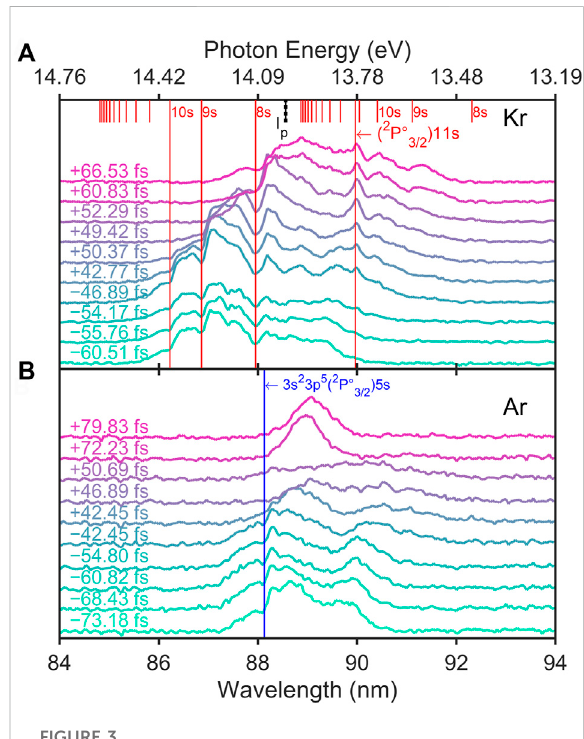
FIGURE 3 Comparison of the 9th-harmonic spectra of Kr (A) and Ar (B) underdifferentchirps. (A) Thepeaklaserintensity ofthechirp-free 42-fs pulse was 1.34 × 10 14 Wcm − 2 . The long red lines are used to highlight absorption and emission under different chirps. (B) There is no fi xed structure in the argon harmonic